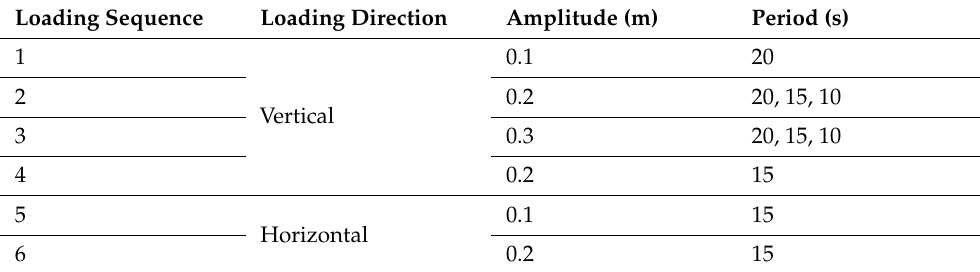
Table 2. Cyclic loading conditions.